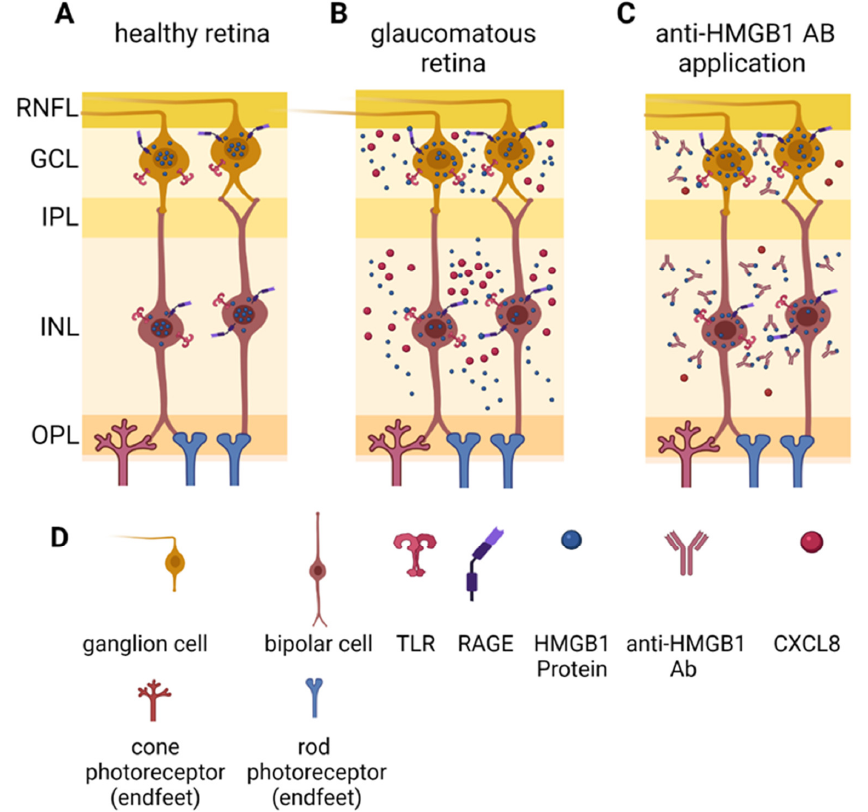
Figure 9. Schematic illustration of a proposed mechanism of anti-HMGB1 Ab application. ( A ) Sche- matic section of the healthy retina. HMGB1 is mainly located in the nucleus. ( B ) Schematic section